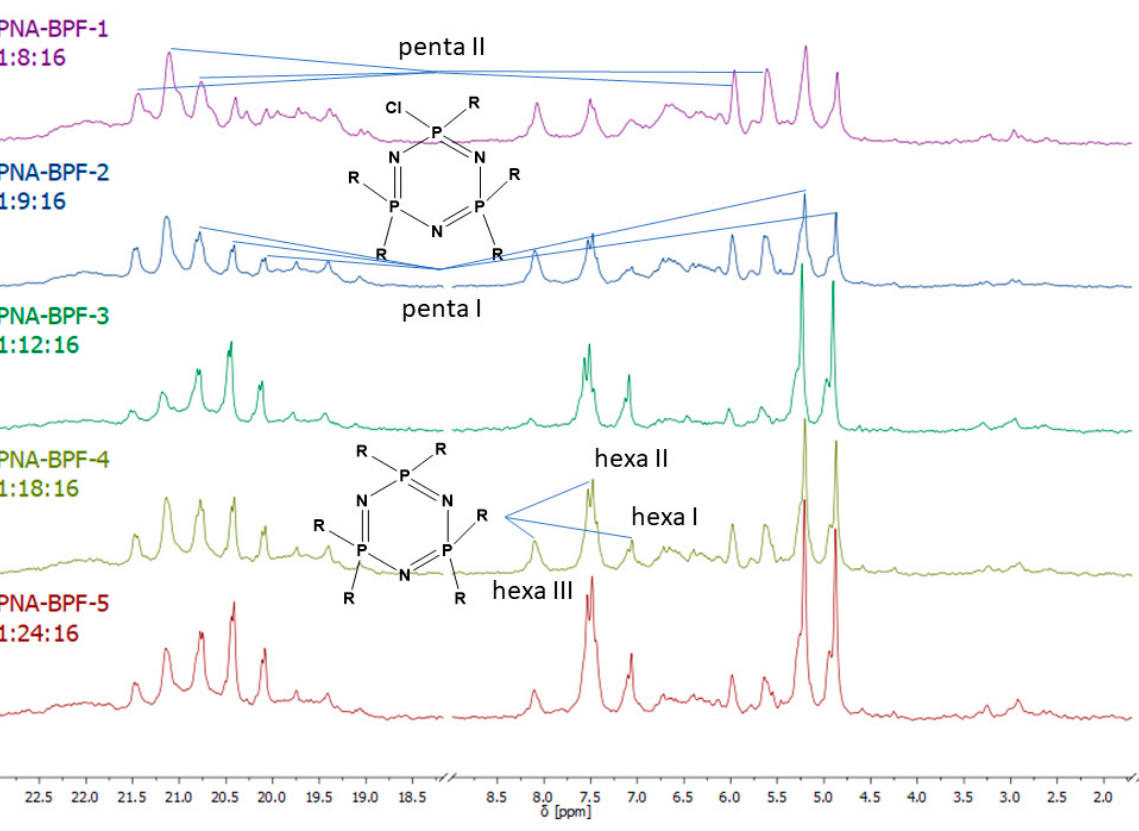
Figure 5. 31 P NMR spectra of